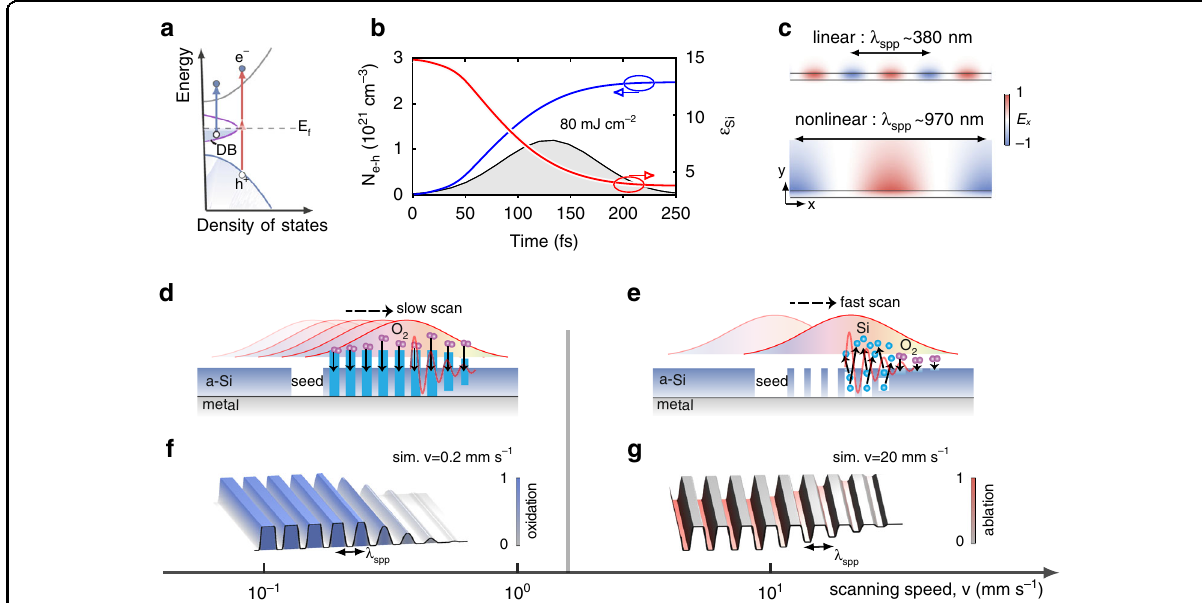
Fig. 3 Formation dynamics of nanogratings. a – c Nonlinear modulations of SPPs by excitation of e – h pairs in Si-on-Ag fi lms under intense ultrafast laser illumination. a Sketch of band structure of amorphous Si, and generation of e – h pairs by two-photon absorption as well as linear absorption due to dangling bonds with light energy lower than band gap. b Transient evolution of spatially averaged e – h pair density, N e-h , and the permittivity (real part) of amorphous Si, ε si , considering a Si-on-Ag fi lm illuminated by a femtosecond laser pulse (shaded area). c Modal pro fi les of SPPs supporting by the Si-on-Ag fi lm in the initial linear regime (upper panel) and with ε si corrected by the e – h pairs (bottom panel). The thickness of the Si fi lm is 50 nm, and the laser pulse has 130-fs duration, 0.08 J cm − 2 fl uence, and 1030 nm wavelength. d – g Sketch of forming oxidized-ridge ( d ) and ablative-groove ( e ) nanogratings by controlling laser scanning speeds, and their exempli fi ed numerical simulations ( f , g ). Both experimentally and numerically, we observe the formation of oxidized-ridge gratings with a scanning speed lower than 0.5 mm s − 1 , and of ablative-groove gratings with a scanning speed higher than 2 mm s −